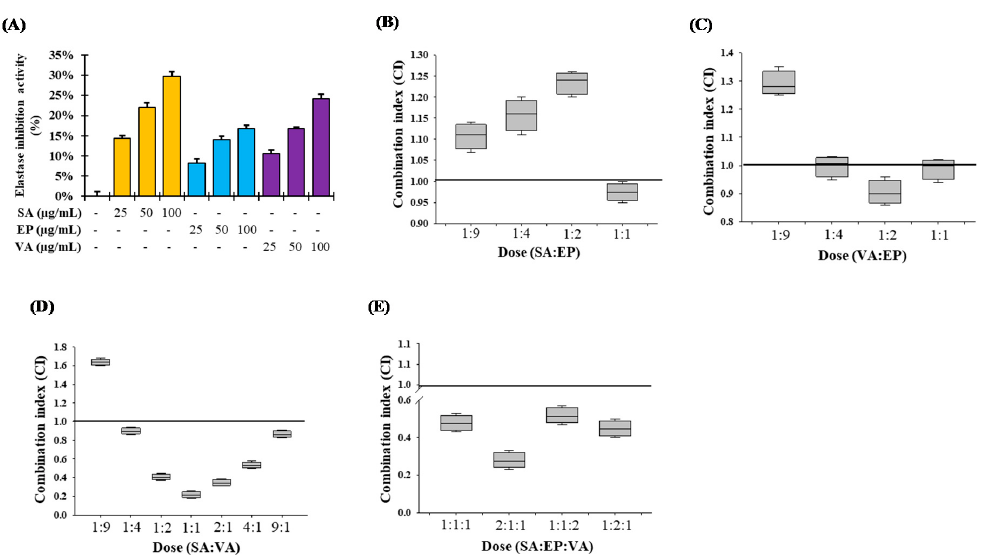
Figure 5. Individual and combination effects of elastase inhibition by the major identified compounds of SSE. ( A ) Elastase inhibition activity of the major identified compounds of SSE. The results are denoted as the mean ± SD from triplicate experiments. ( B – E ) Combination e ff ects of elastase inhibition by the major identified compounds of SSE. Combination index (CI) values of < 1, = 1, and > 1 indicate synergism, additive e ff ect, and antagonism, respectively. CI values shown are mean ± SE with a minimum of three experiments. SA: syringic acid; EP: epicatechin and VA: vanillic acid. The raw compuSyn report are given in supplementary